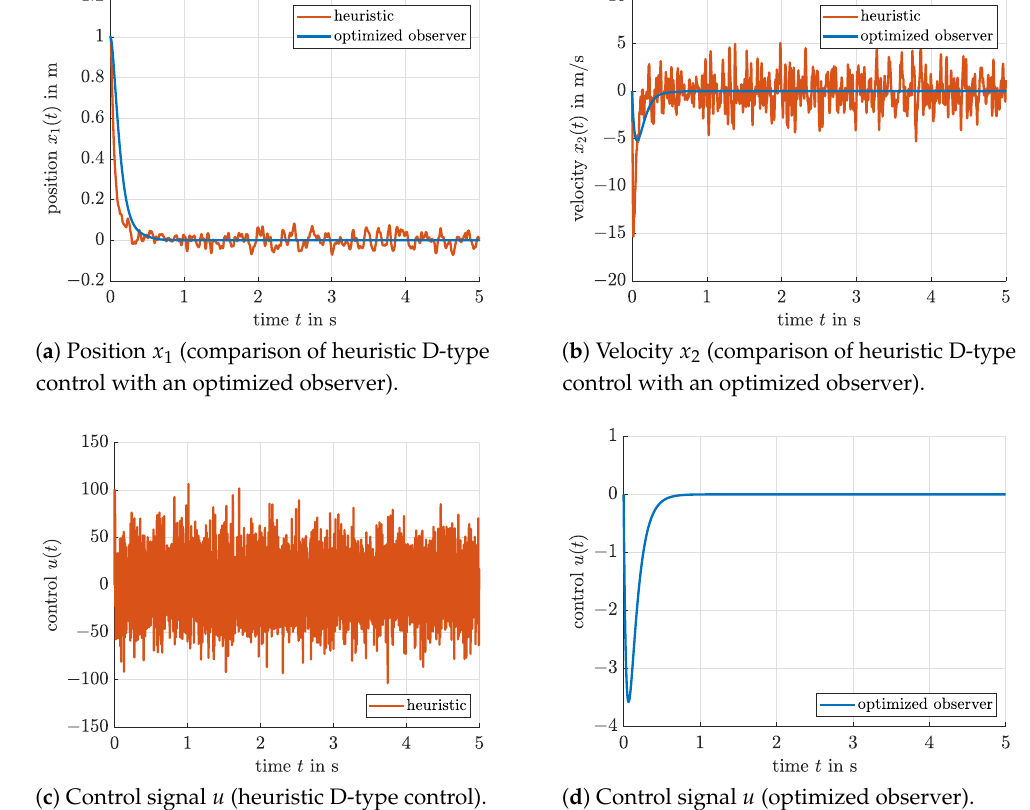
Figure 7. Comparison of a heuristic D-type control approach with an optimized observer from the previous work